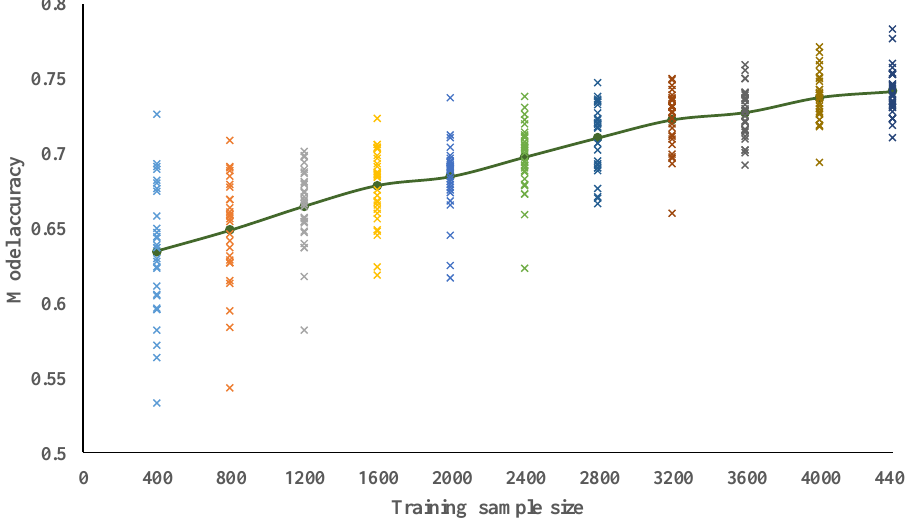
Figure 8. Model accuracy for spectral-yield displacement 𝑆 𝑑𝑦 with 20 building characteristics.